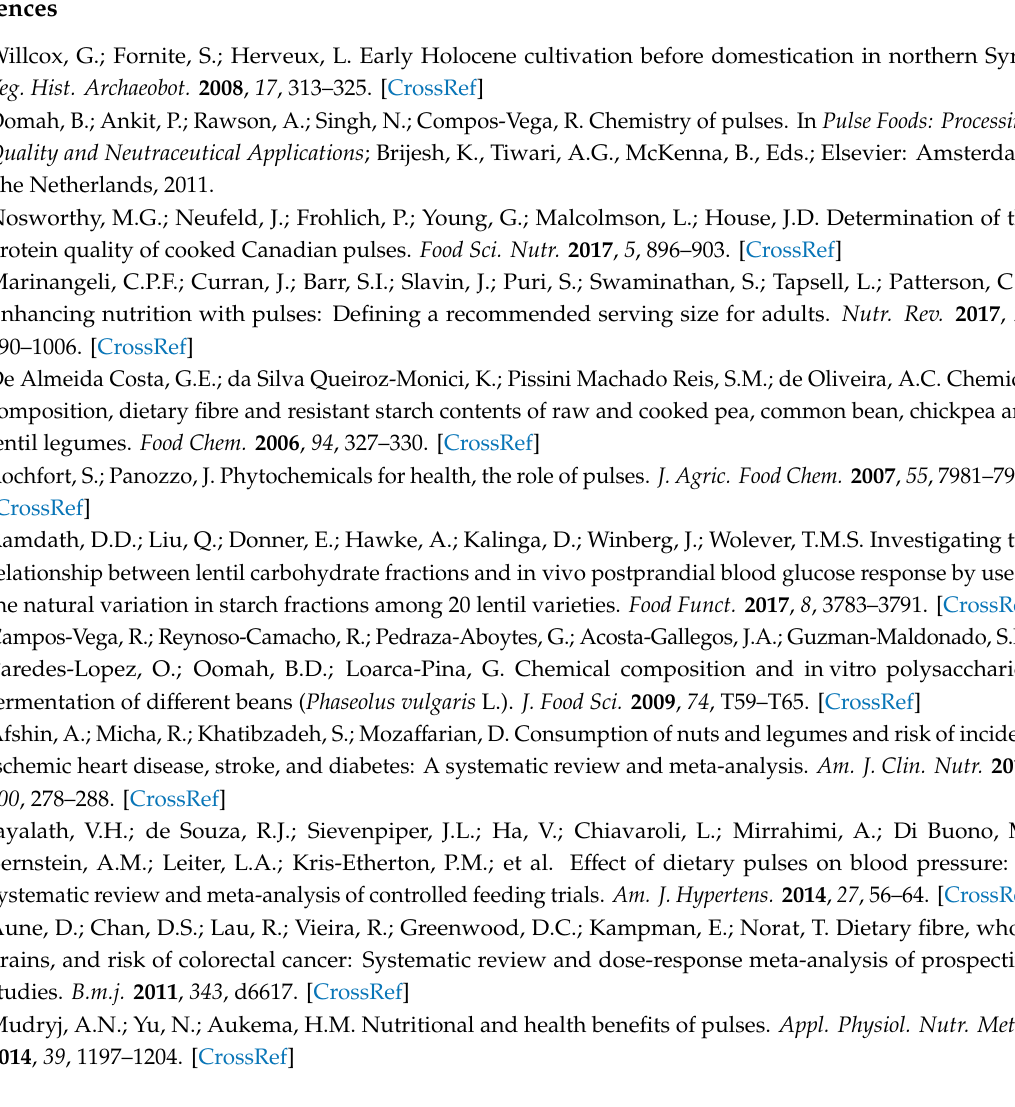
Figure S1: Predicted functions of the metagenome, Table S1: Colon mRNA expression in mice fed experimental diets for 3